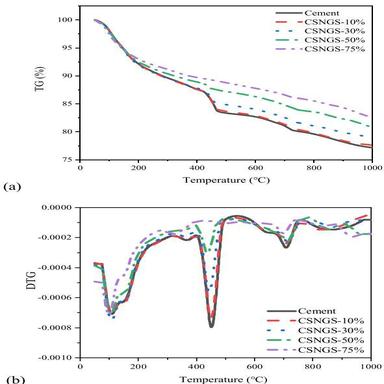
TG and DTG curves of paste with various OPC/CSNGS proportion, (a) TG (b) DTG.